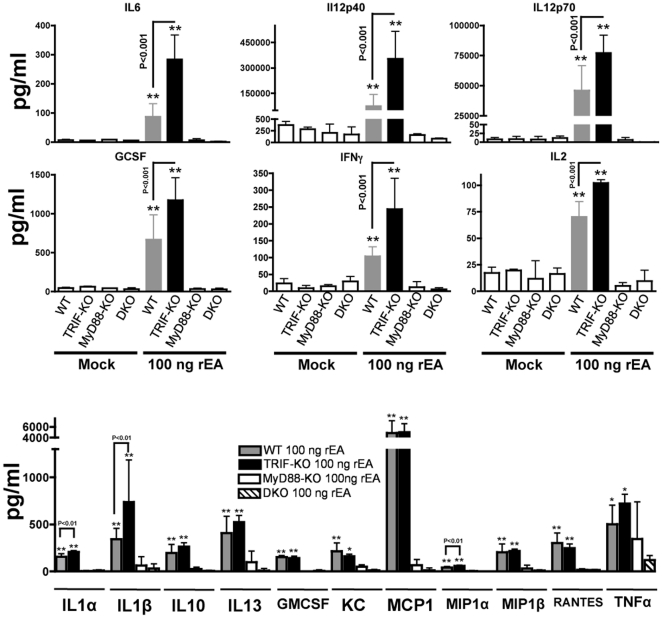
TRIF negatively regulates rEA-mediated MyD88 dependent activation of pro-inflammatory cytokines and chemokines in vivo.C57BL/6 WT (N = 9), MyD88-KO (N = 3), TRIF-KO (N = 3–4), and MyD88/TRIF-DKO (N = 4) mice were injected with 100 ng of rEA. Plasma samples were collected at 6 hpi and were analyzed using a multiplexed bead array based quantitative system. All genotype mock-injected mice (N = 2–3) were included in analysis. One of two representative experiments is shown. Statistical analysis was completed using a one-way ANOVA with a Student-Newman-Keuls post-hoc test. The bars represent Mean ± SD. *, ** - Indicate plasma cytokine values that are statistically different from those in mock injected animals, p<0.05, p<0.001 respectively. No significant differences between mock-injected animals of different genotypes were detected. No significant activation of cytokines was observed in MyD88-KO and MyD88/TRIF-DKO animals.